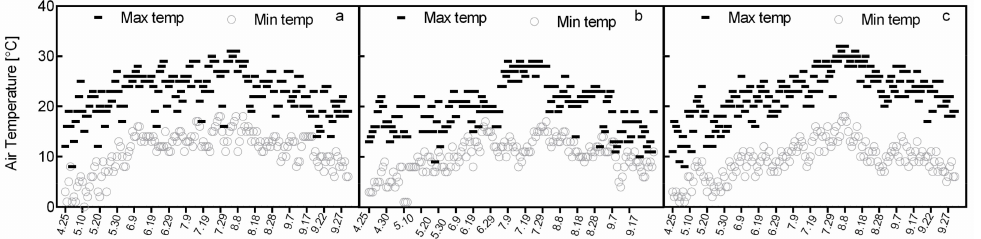
Figure 2. Minimum and maximum air temperature for ( a ) 2014, ( b ) 2015 and ( c ) 2016 cropping season.